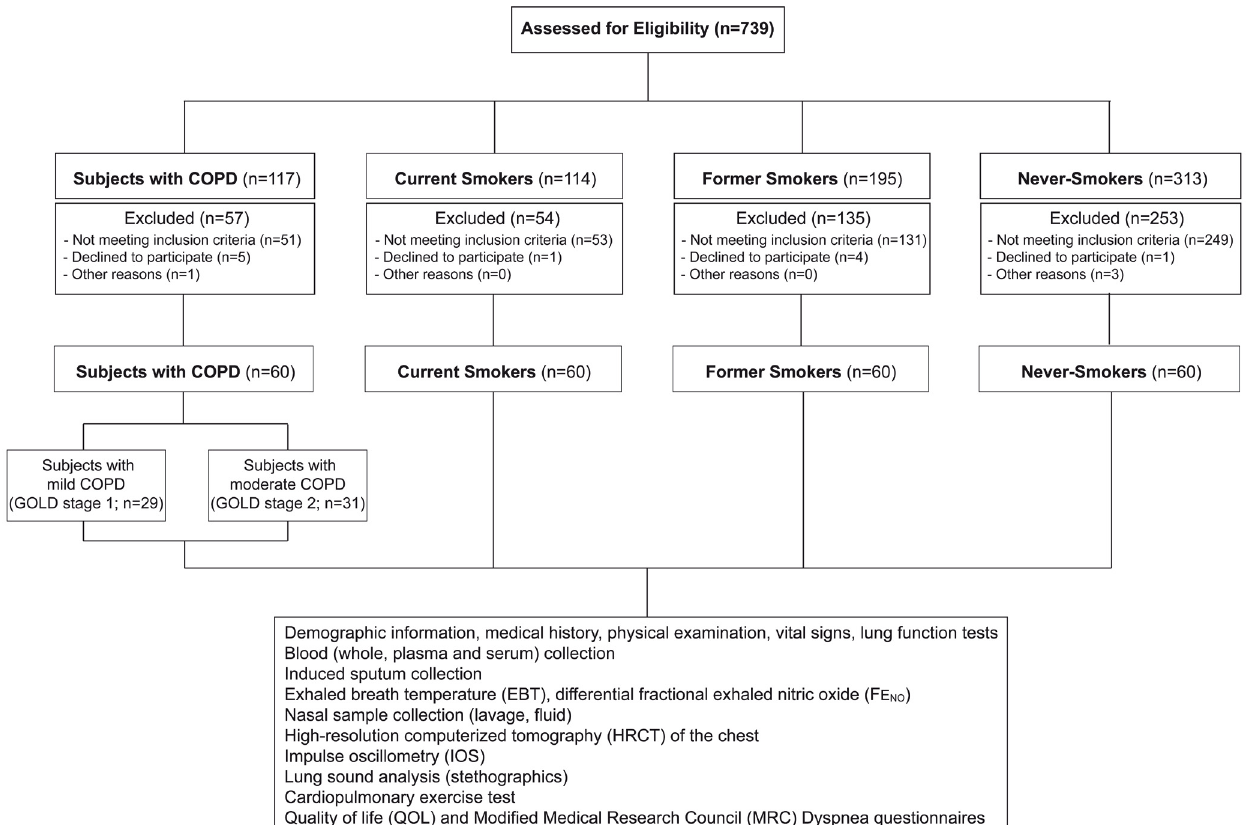
Figure 1. CONSORT flow diagram of the progress through the phases of this study (i.e. enrolment, allocation, visits/measurements, and data